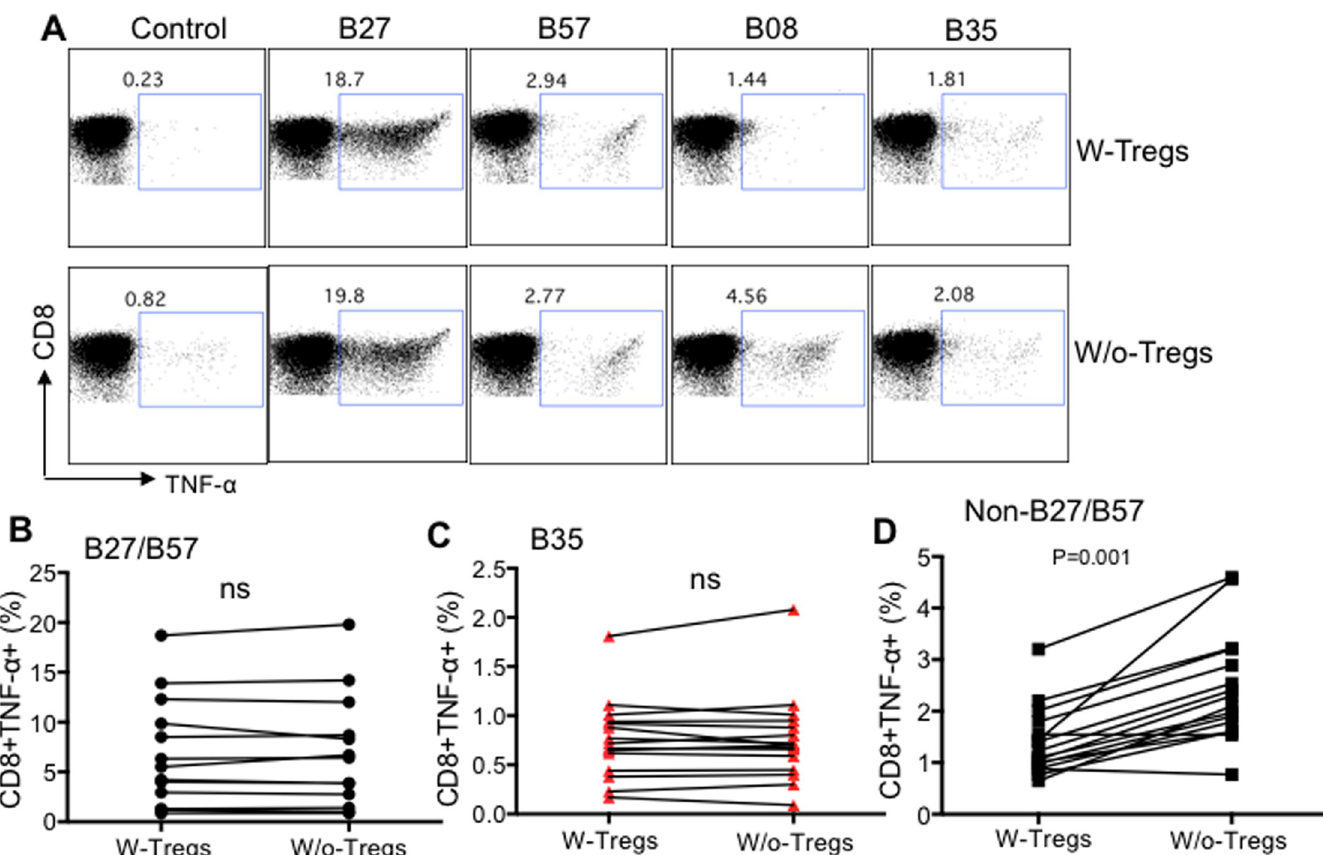
Fig 4. Differential suppression of TNF- α by Tregs depending on the HLA-allele restriction of CTLs. A ) Representative flow cytometry plots of % TNF- α production by CD8 + T cells restricted by different HLA-alleles, as shown, following stimulation with their cognate epitopes (2 μ g/ml for 72 hrs) measured by ICS in the presence or absence of autologous Tregs. B-D ) Cumulative data showing %TNF- α secreting CD8 + T cells restricted by either HLA-B � 27/B57, HLA-B � 35Px or non-HLA-B � 27/57 following stimulation with their cognate epitopes (2 μ g/ml) for 72 hrs as measured by ICS. Each point represents data from an epitope.